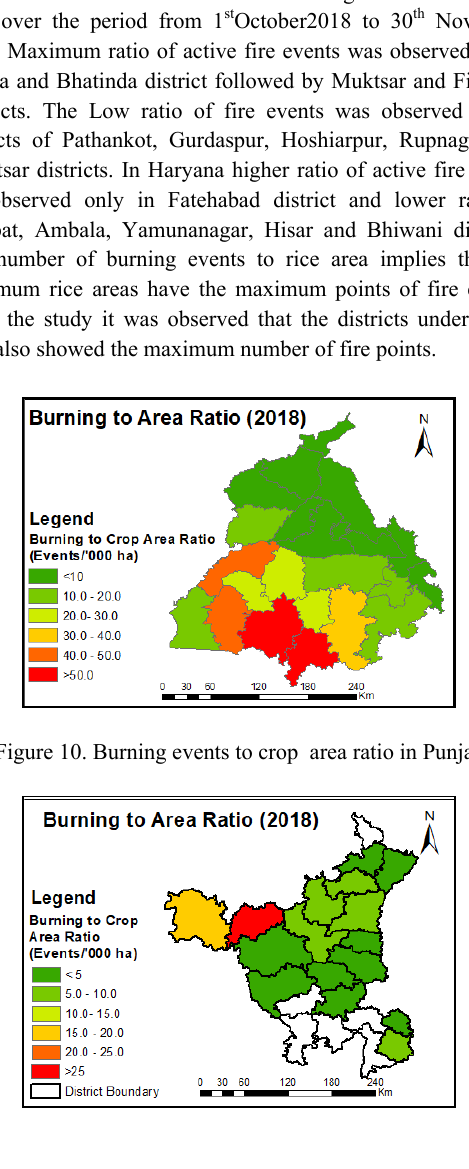
Figure 6. Maximum rice residue burning period of Punjab